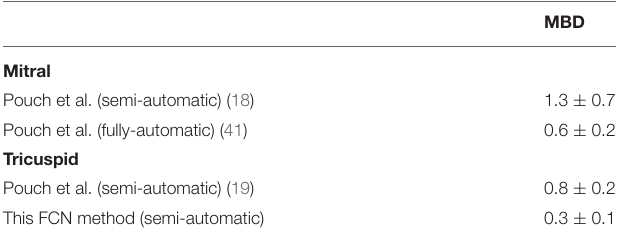
TABLE 8 | Comparison of MBD of the merged leaflet structure between previously published techniques and our current FCN